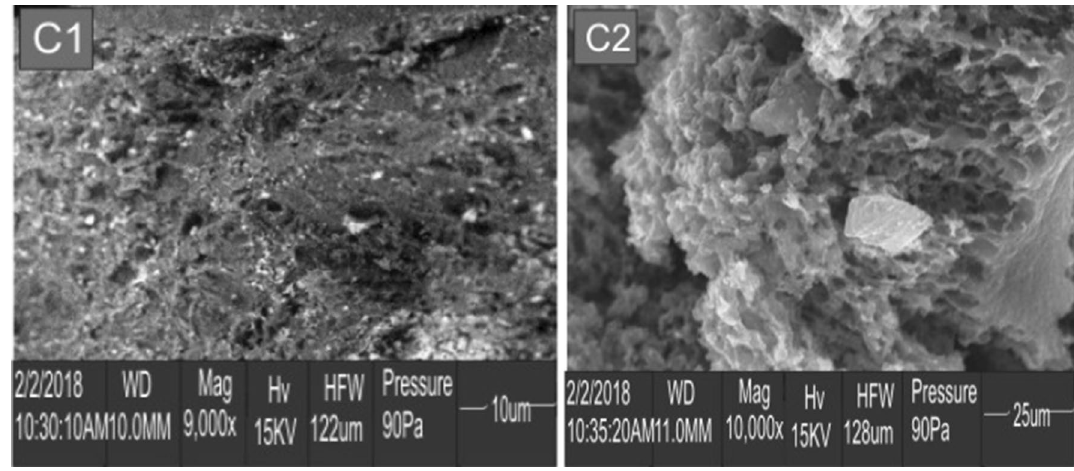
Fig. 3 SEM images of LLAC adsorbent a before and b after loading of